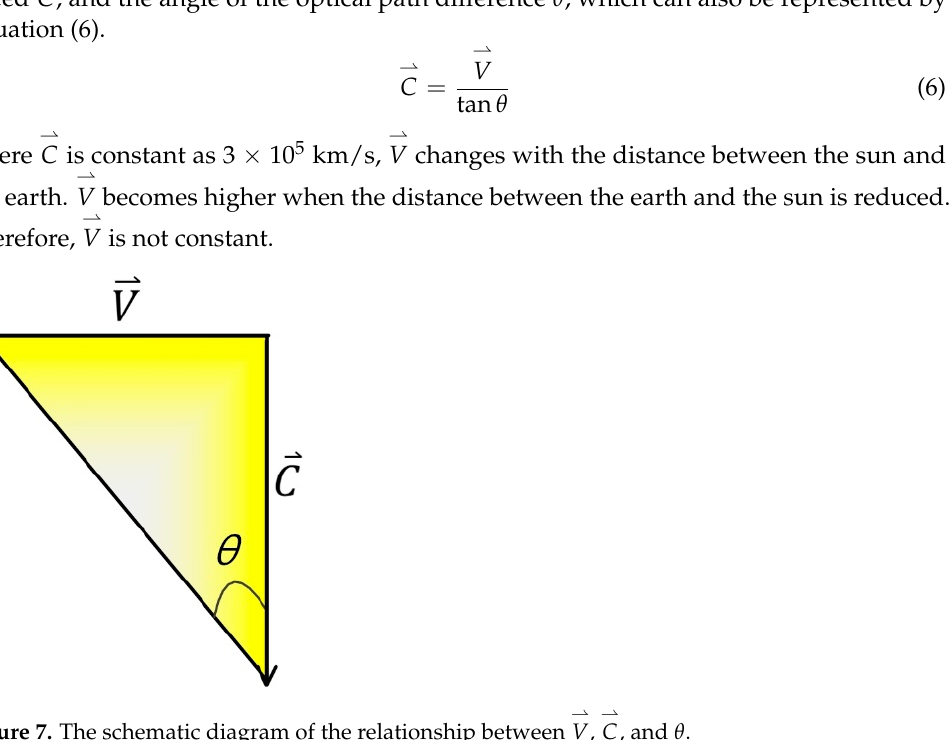
Figure 7. The schematic diagram of the relationship between 𝑉(cid:4652)⃑ , 𝐶⃑ , and θ .